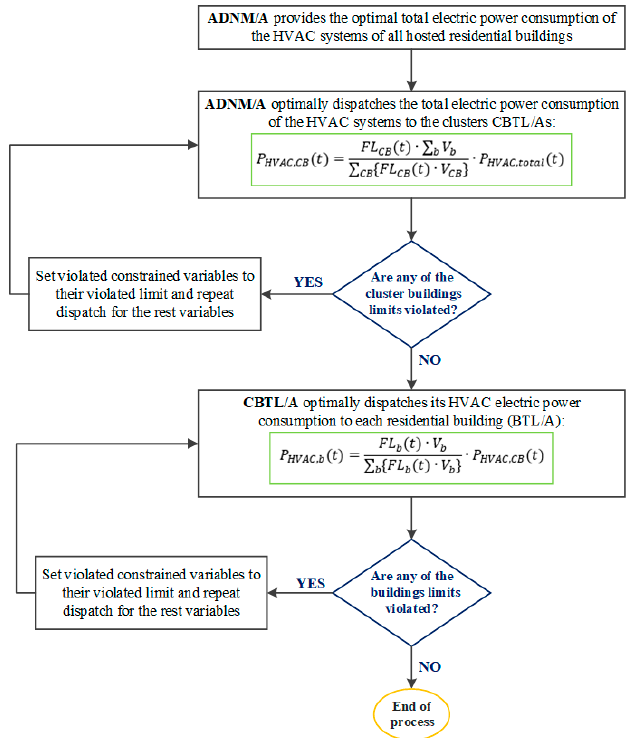
Figure 6. Flowchart of the optimal power dispatch of the buildings’ HVAC system.